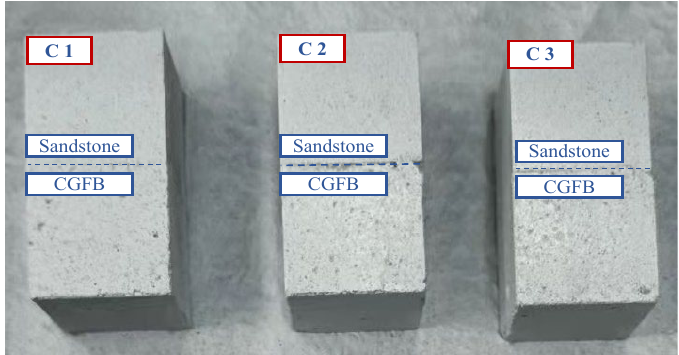
Figure 4. The speckle fields of sandstone–CGFB composite samples.